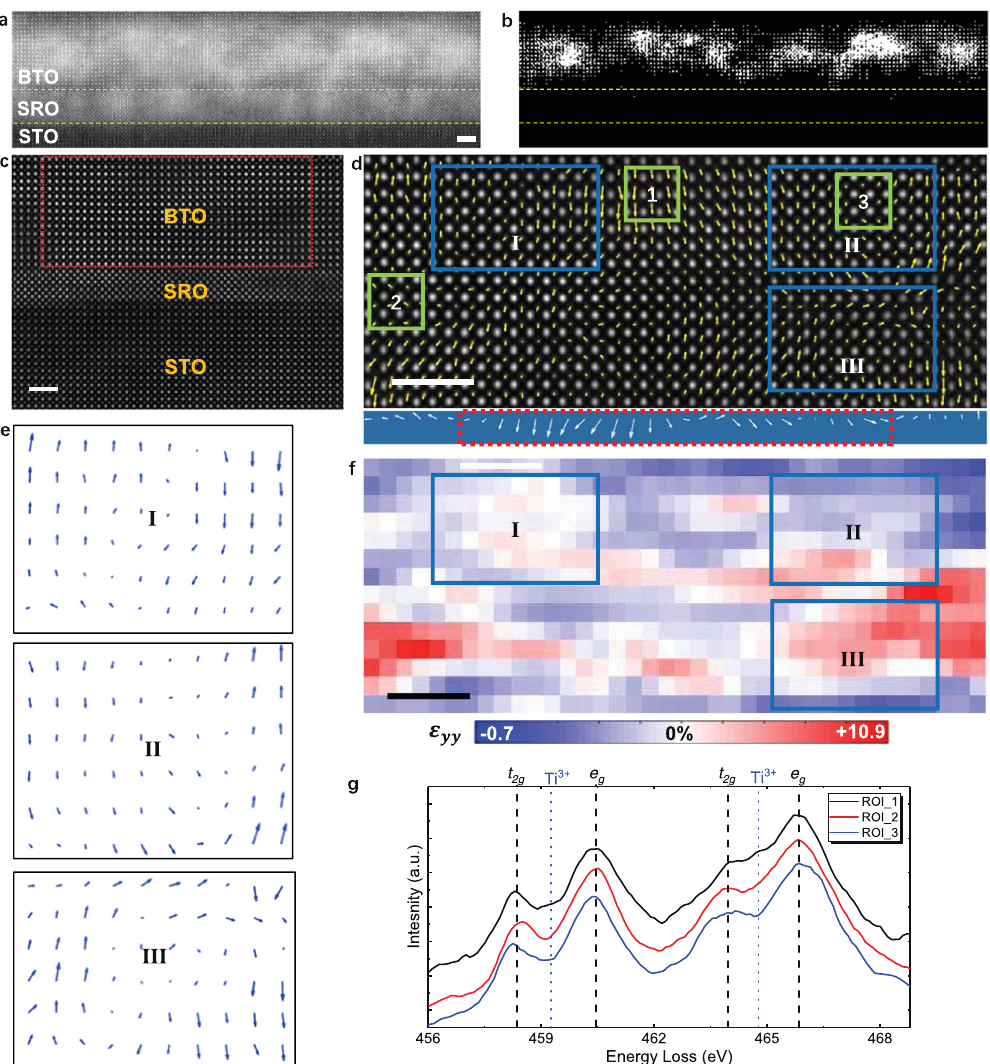
Fig. 4 STEM observation of 5-BTO. a A LAADF-STEM image of the 5-BTO/SRO/STO heterostructure. The cloudy contrast in BTO indicates the existence of extra strain fi elds due to oxygen vacancies. b The processed image of ( a ) with adjusted contrast to show clearly clustered regions with cloudy contrast in the middle of BTO. c A HAADF-STEM image of the 5-BTO/SRO/STO heterostructure, showing sharp heterointerfaces. d Ti-displacement vector mapping of BTO for the region indicated by the red square in ( c ). The lower panel shows the average Ti- displacement of each atomic column, with the red dashed square marking a dominant downward polarization state. e Magni fi ed regions of Ti- displacement vectors for a half vortex (Domain I), half antivortex (Domain II), and vortex (Domain III), as indicated by the blue squares in ( d ). f Out-of-plane strain mapping of the same BTO region in ( d ), showing considerable inhomogeneity. g Ti- L 2,3 electron energy loss spectra (EELS) of region-of-interest (ROI)-1, 2, and 3, as marked by the green squares in ( d ). The scale bars are all 2